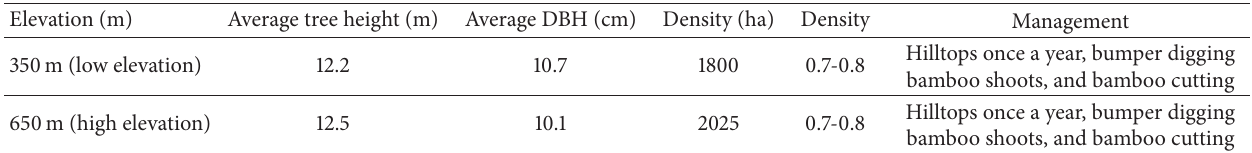
Table 1: The stands characteristics at research sites.